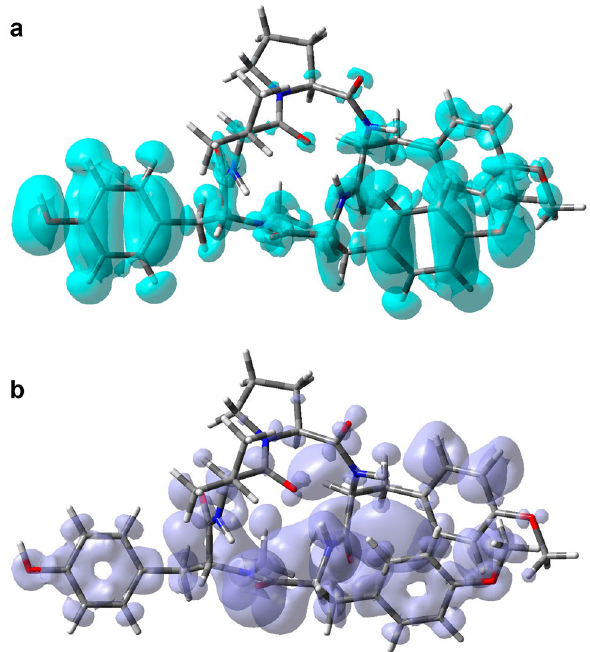
Figure 5. Graphical representation of the dual descriptor DD of Aspergillipeptide D. Top: DD > 0, Bottom: DD <